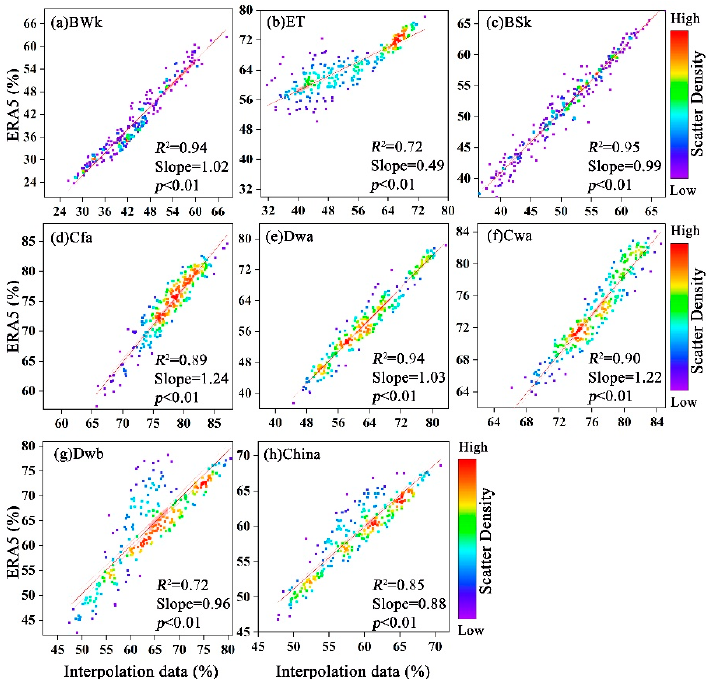
Figure 13. Comparison and verification of interpolation data and the European Centre for Medium- Range Weather Forecasts Reanalysis 5 (ERA5) data of precipitation for selected Köppen–Geiger clas- Table 3 for explanations of the abbreviations).